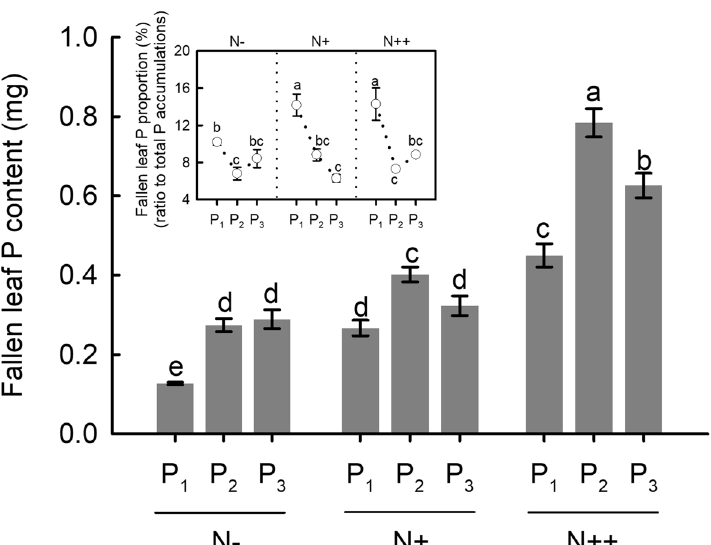
Fig. 3 Fallen leaf P content and the fallen leaf P proportion of P. edulis seedlings in response to experimental N deposition rate under different soil P availability. Different lowercase letters indicate significant differences among different treatments (Tukey’s HSD, α standard error from the mean at each sampling ( n =